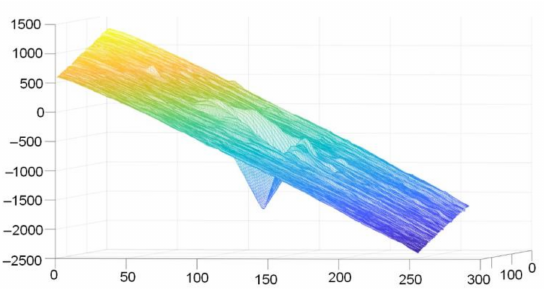
Figure 6. Predicted topographical image of indent for load 2000 µ N, holding time 30